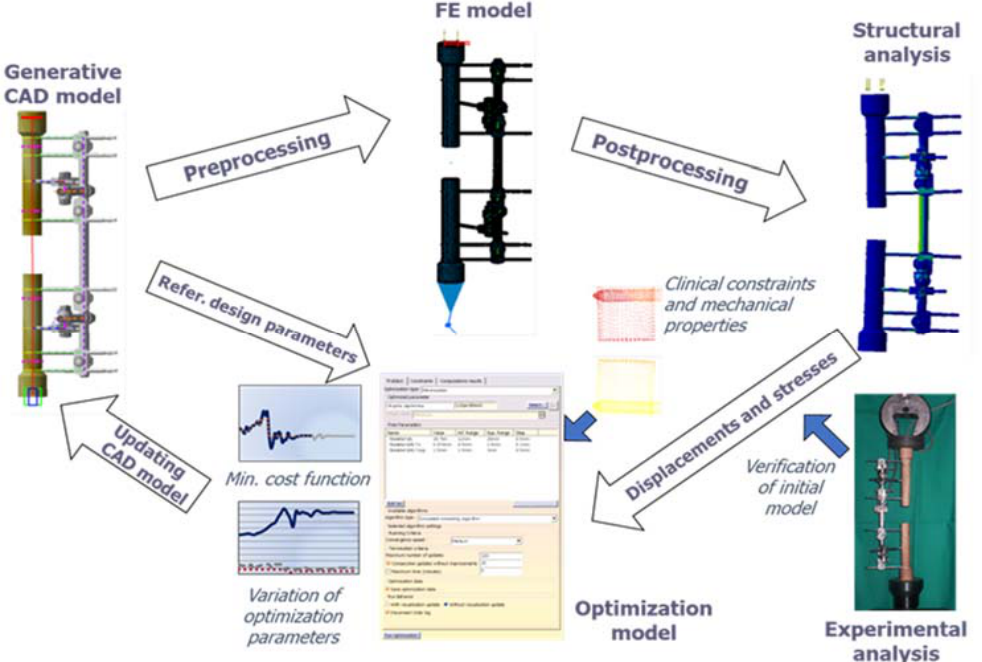
Figure 1. Concept of developed KBE system.